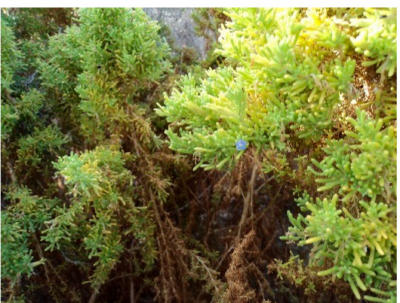
Figure 1. Picture of N. ramosissima I.M. Johnst. Collected in Paposo Valley, Atacama Desert, in October